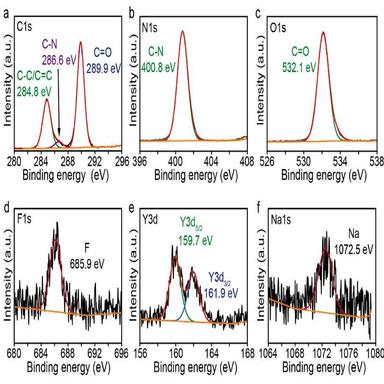
XPS spectra of UCNPs@cd-CA for a) C1s, b) N1s, c) O1s, d) F1s, e) Y3d, and f) Na1s.